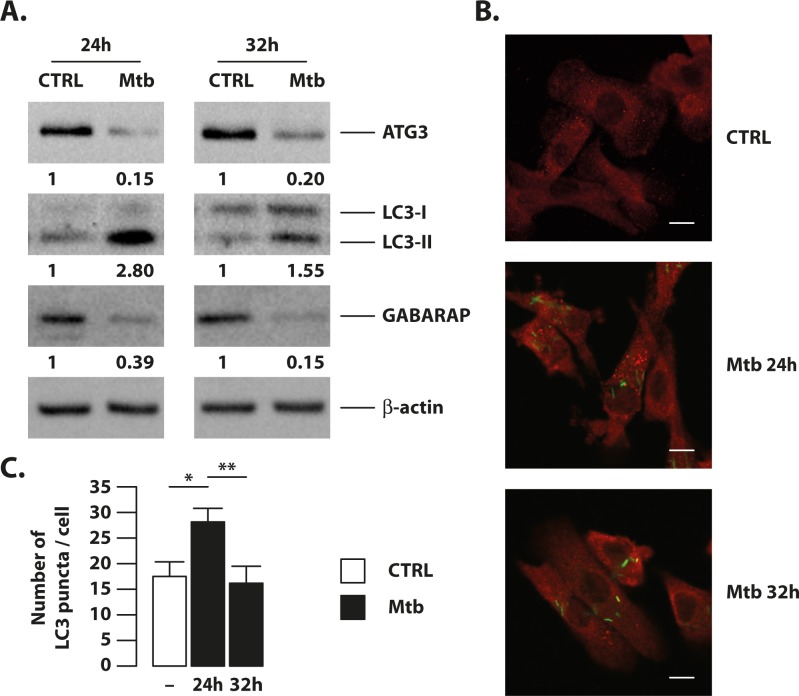
Mtb down-regulates Atg3 protein level and autophagosome number at later time point of infection.DC were infected with Mtb for 24 and 32 hours or left untreated (CTRL). (A) Atg3, LC3 and GABARAP levels were determined by Western blotting by using specific primary antibodies. Band intensity quantification is indicated at the bottom of each immunoblot. Actin levels were analyzed to verify the amount of loaded proteins. The results shown are representative of three independent experiments that yielded similar results. (B) Immunofluorescence analysis of the number of LC3 puncta per cell in Mtb-infected DC. DC were infected with Mtb for 24 and 32 hours or left untreated (CTRL), fixed and then stained with auramine to color Mtb bacilli (green) and with an anti-LC3 antibody (red). Representative images are shown in panel C. Scale bar 20 μm. (C) Graphic reporting a quantification of the number of LC3 puncta per cell performed as indicated in Material and Methods. The results represent the mean ± the standard error of the mean of three independent experiments (*p = 0.005; **p = 0.003).